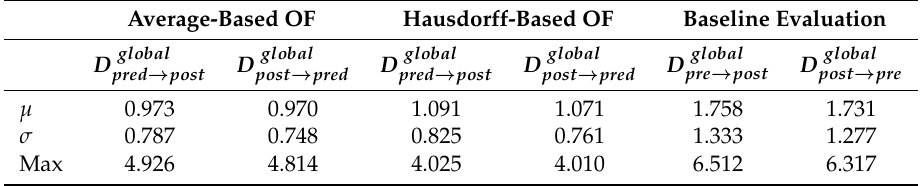
Table 6. Numerical evaluation: Global distance (in mm) based on both average and Hausdorff OFs for training set sampled with 65%, and 75%, respectively. The last two columns denote the evaluation of the dummy method.